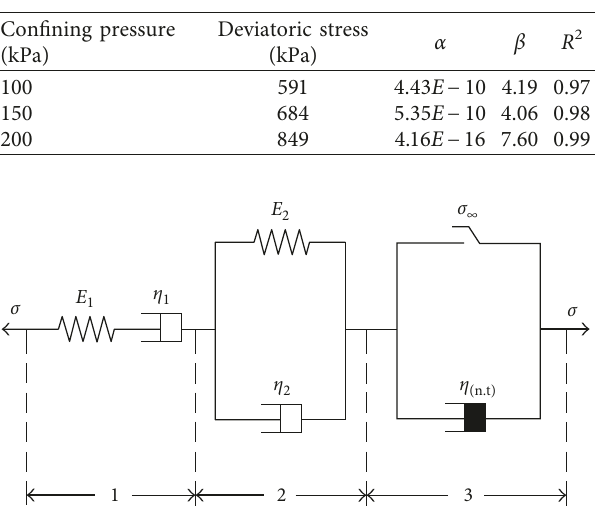
Figure 10: Illustration of the improved Burgers damage model.